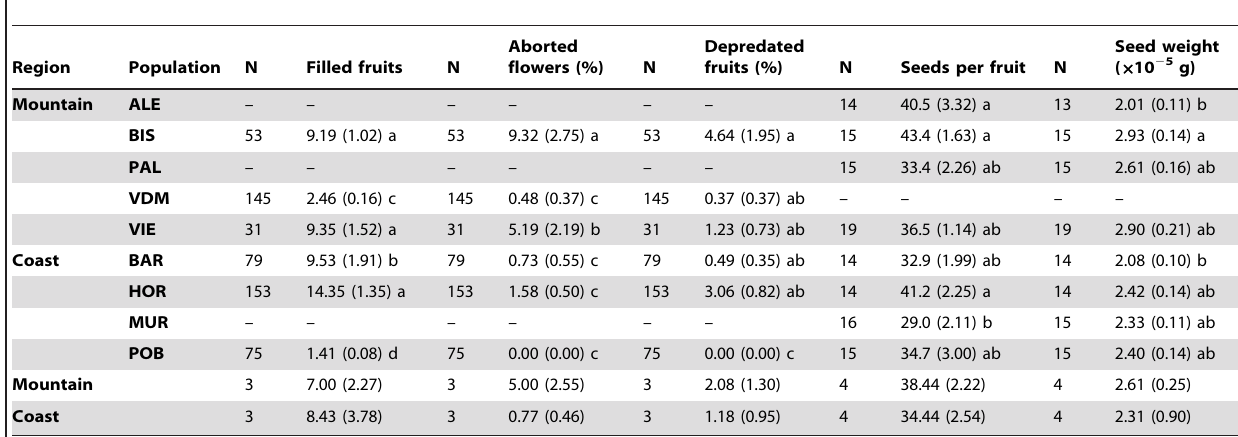
Table 3. Sample size and mean ( 6 SE) values for reproductive parameters of A. thaliana .